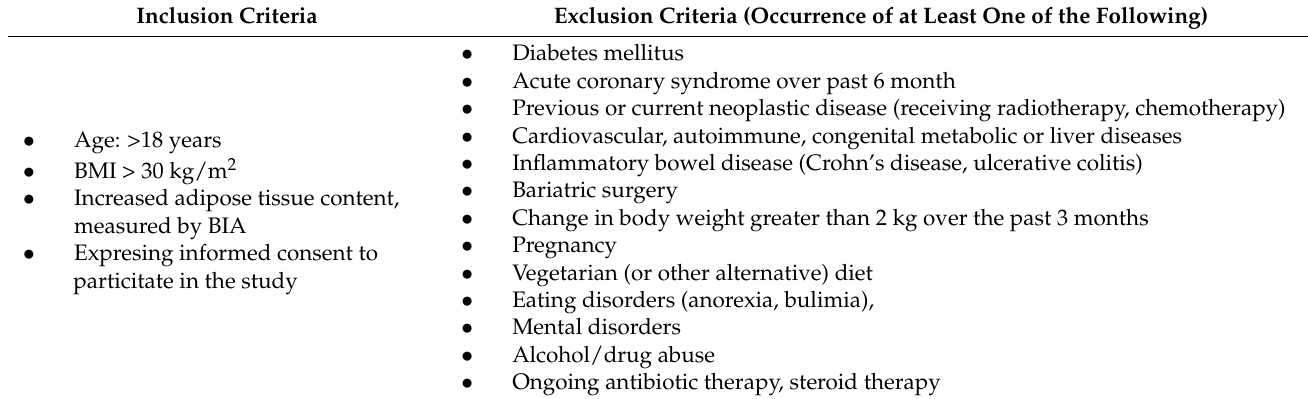
Table 1. The inclusion and exclusion criteria for the study. Inclusion